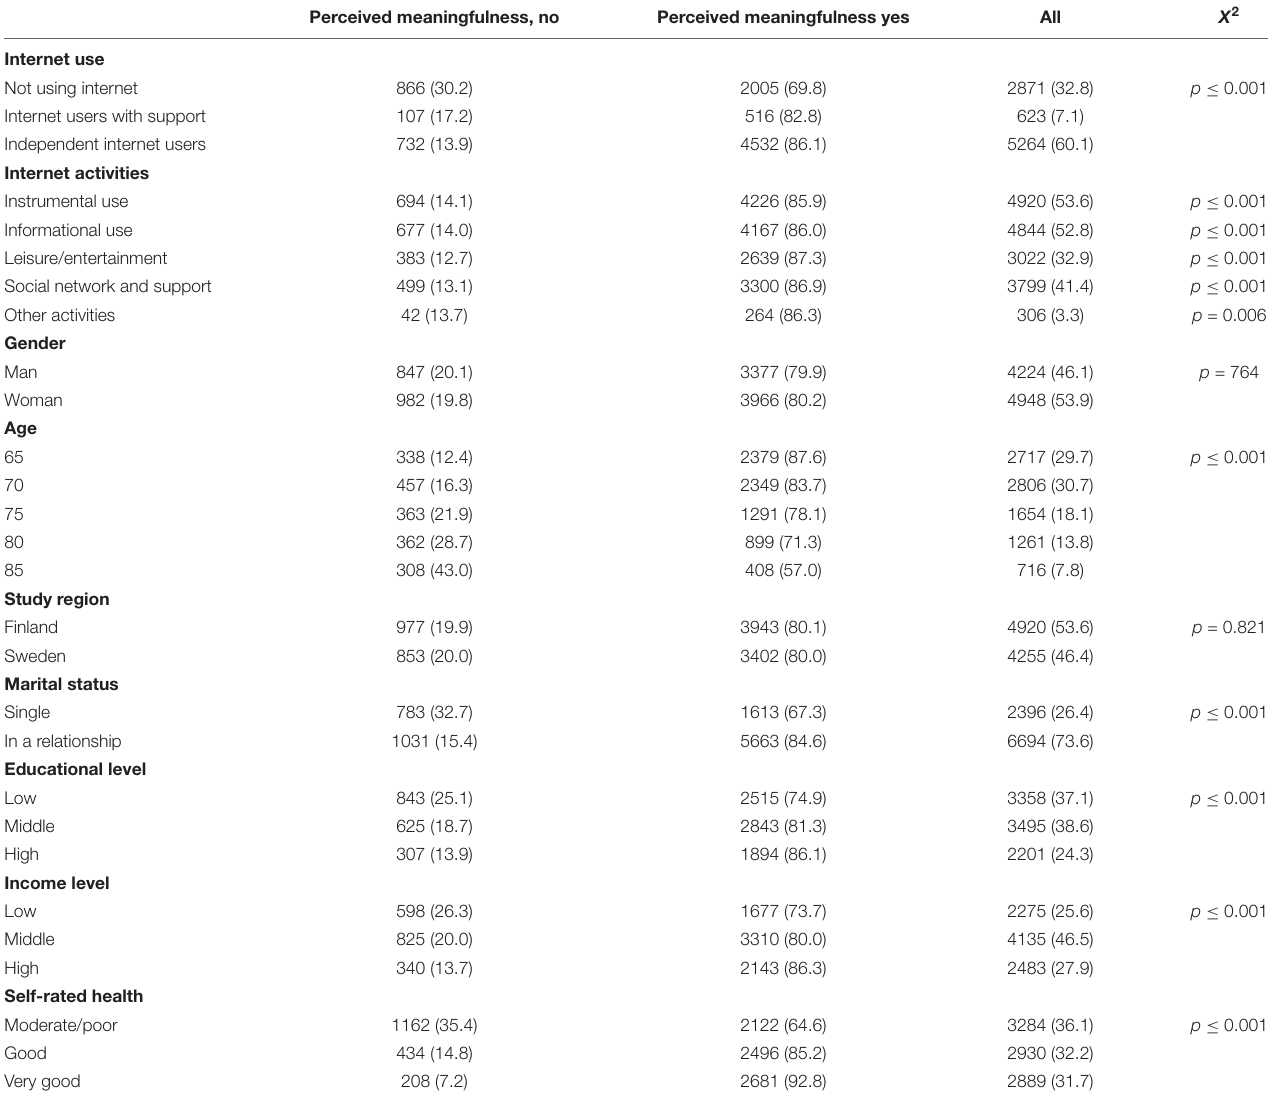
TABLE 1 | The distribution of perceived meaningfulness among all the included variables and results from Person’s chi-square test presenting between-group comparison of perceived meaningfulness. Perceived meaningfulness, no Perceived meaningfulness yes